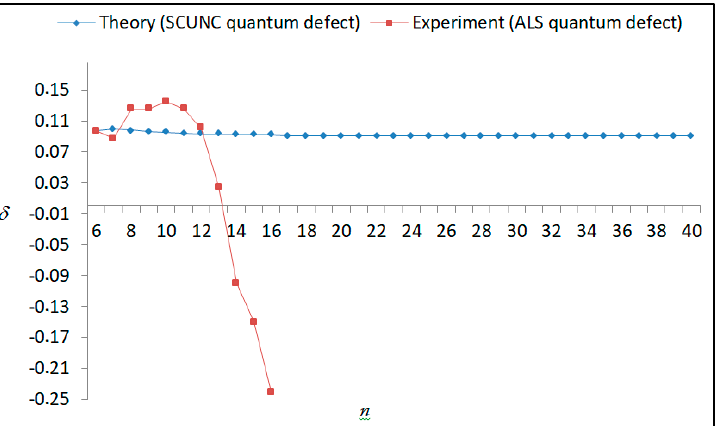
Figure 11. Variations of the quantum defect ( δ ) with the principal quantum number n for the 4 s 2 4 p 2 ( 1 D 2 ) nd ( 2 S ) Rydberg series originating from the 2 P ◦ 1/2 metastable state of Se + converging to the 3 P 2 series limits in Se 2+ .